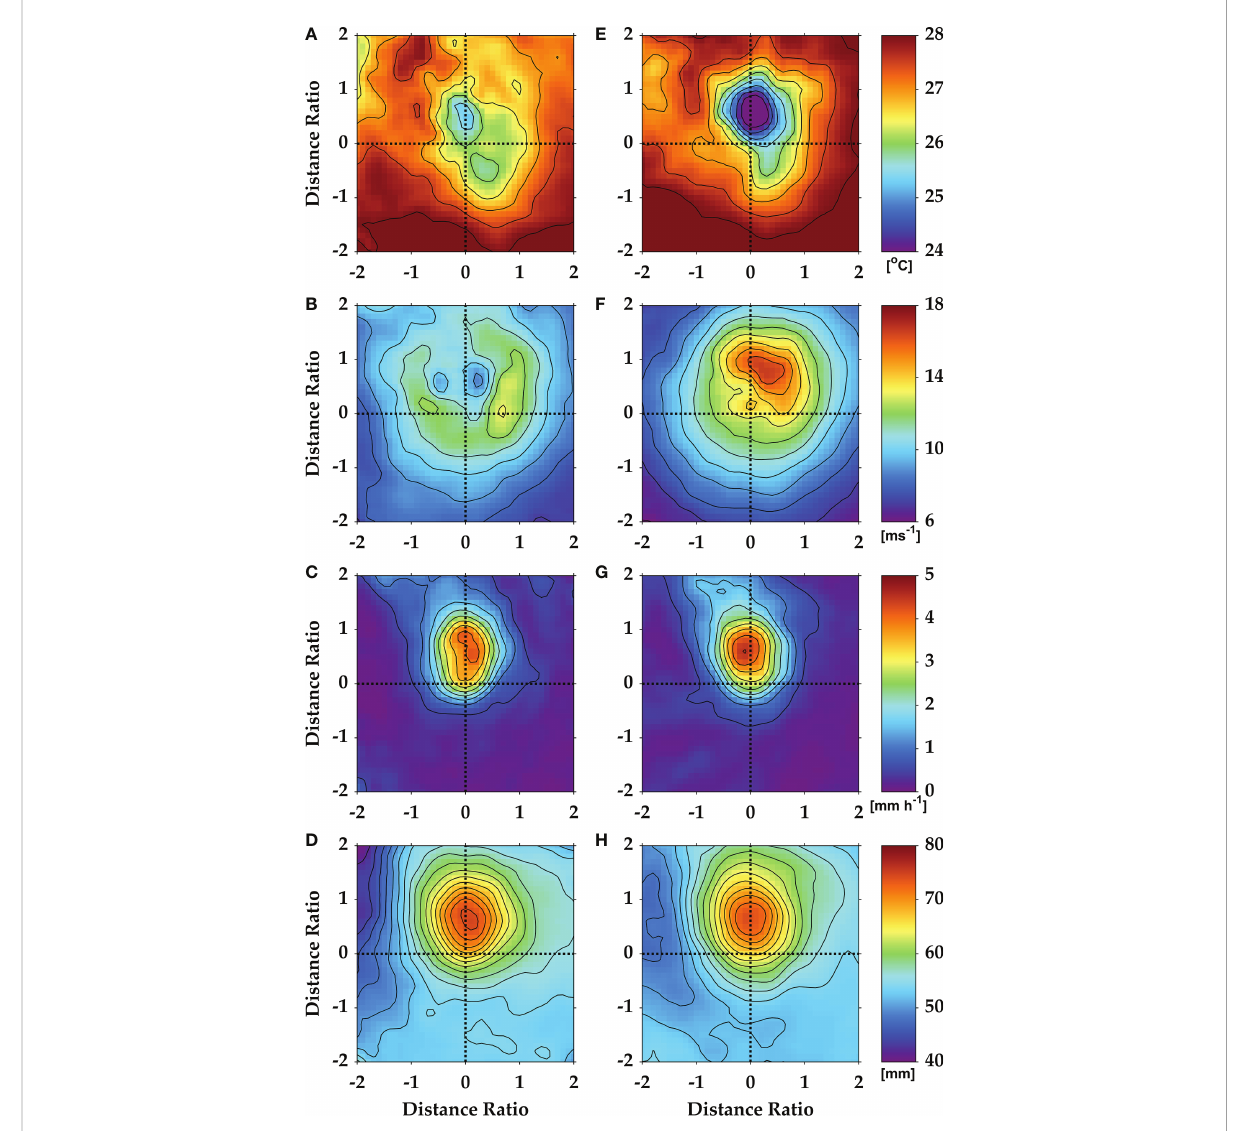
FIGURE 14 Spatial distributions along-typhoon components of (A) SST (°C), (B) wind speed (m s -1 ), (C) precipitation rate (mm h -1 ), and (D) total column water vapor (or total precipitable water vapor) (mm) in the rotational coordinate system as a function of distance ratio from a typhoon center in the Northwest Paci fi c using Aquarius data. (E – H) are the cases using SMAP